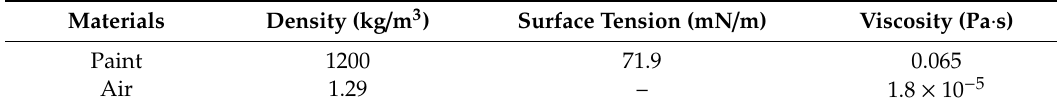
Table 2. The properties of the liquid and